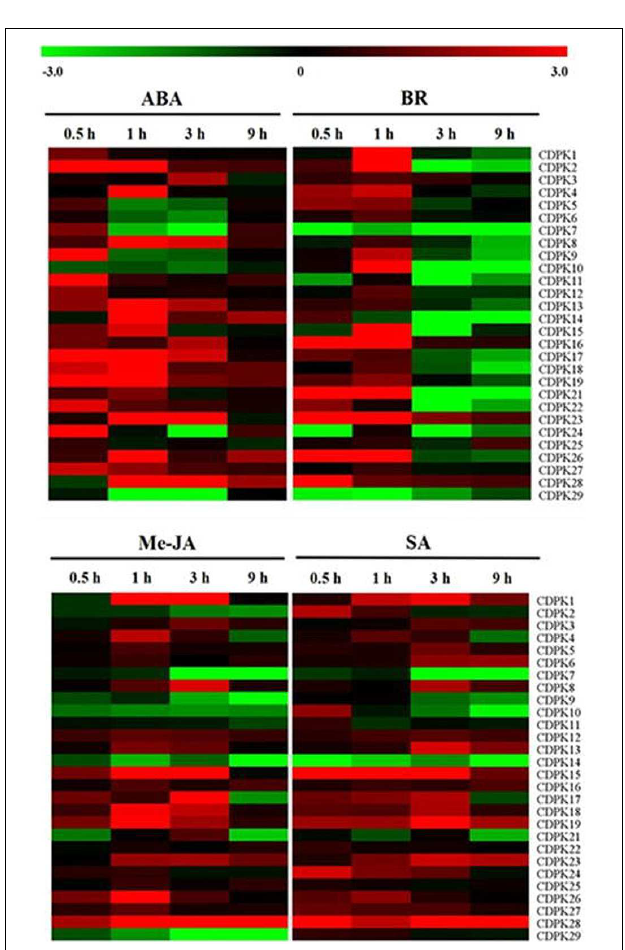
FIGURE 6 | Expression analysis of 28 CDPK genes in leaves of tomato in response to phytohormones. Leaves were exposed to ABA at 100 µ M, EBR at 200 nM, MeJA at100 µ M and SA at 2 mM and sampled at various times for the quantitative real-time RT-PCR analysis. The color scale stands for the relative signal intensity values.